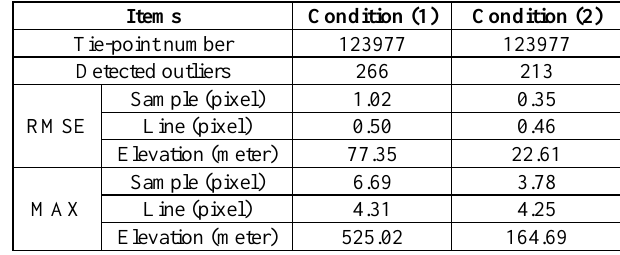
Table 2. Statistic information of the block adjustment results of condition (1) and condition